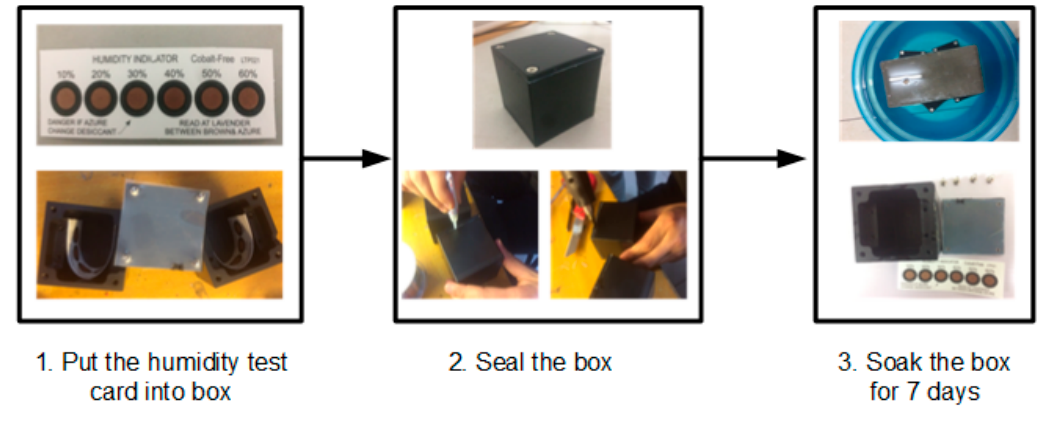
Figure 3 . Waterproof testing. Figure 3. Waterproof testing.